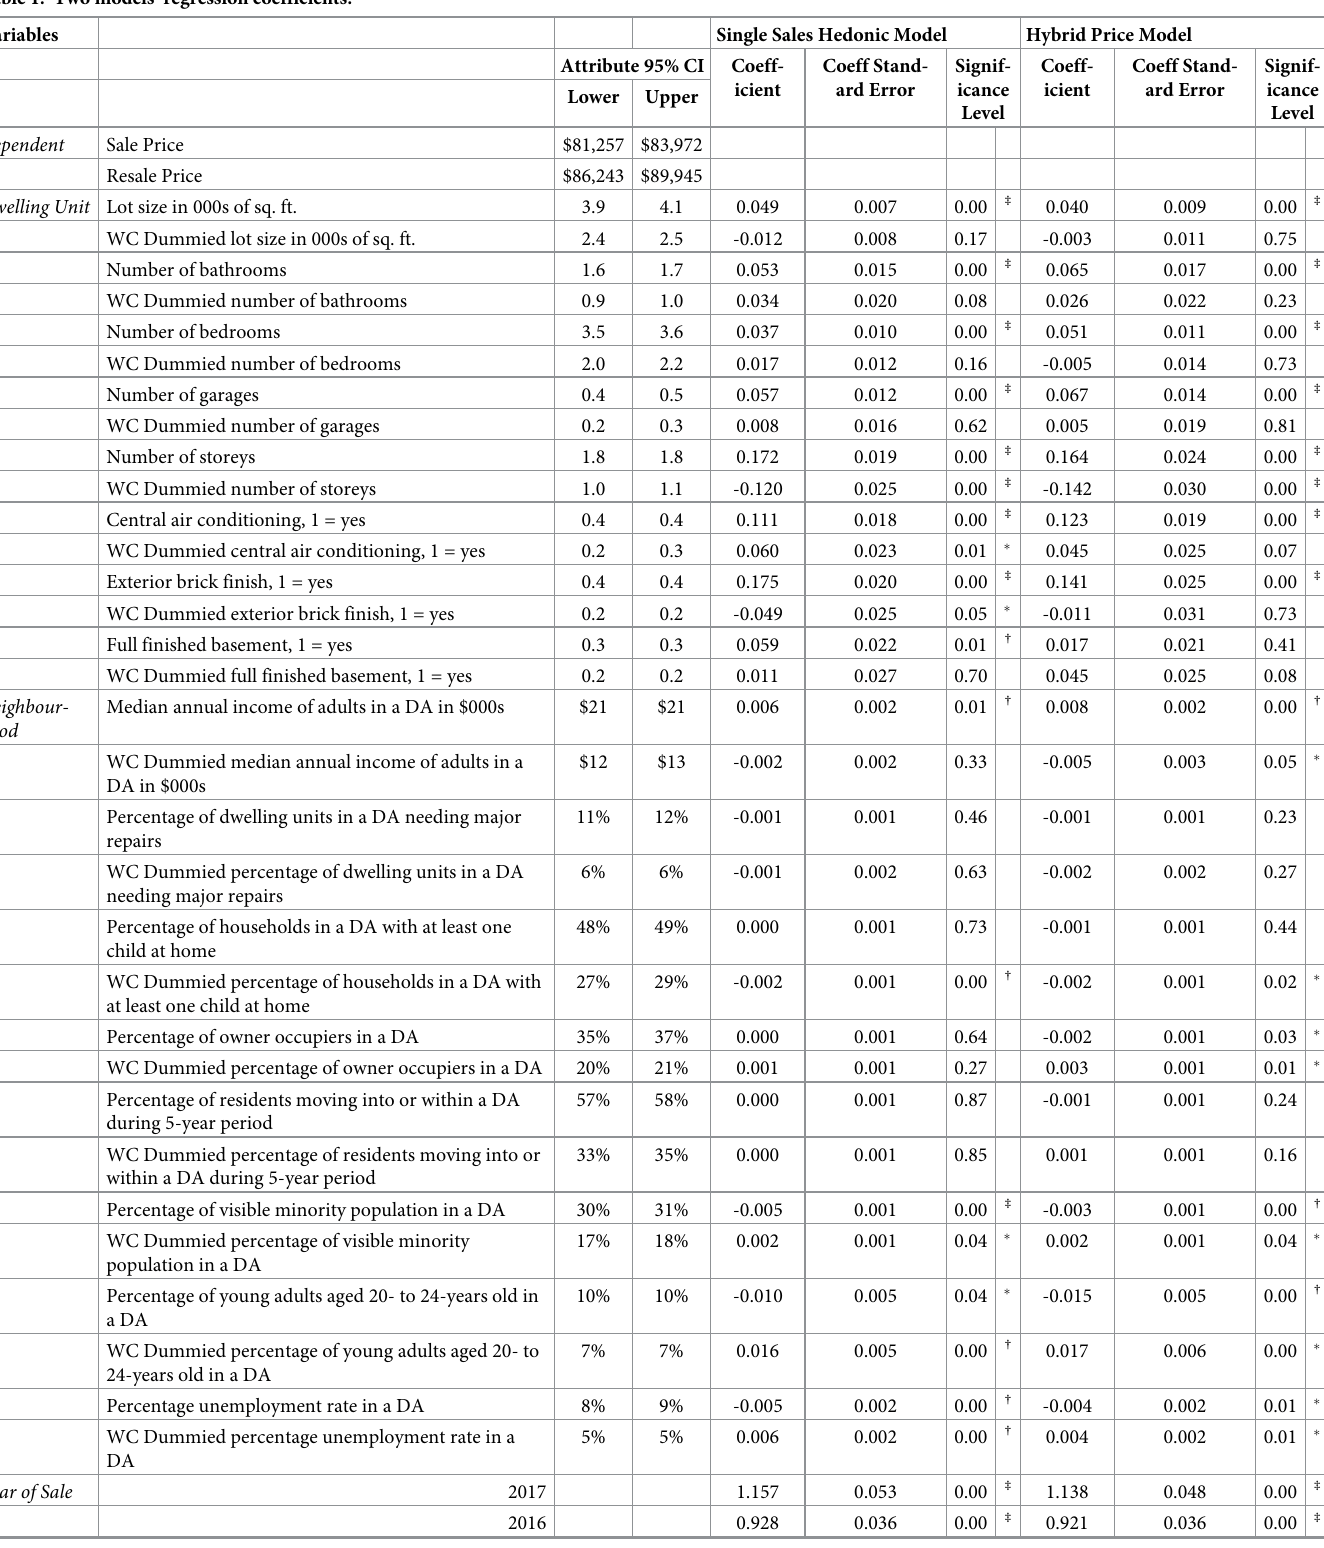
Table 1. Two models’ regression